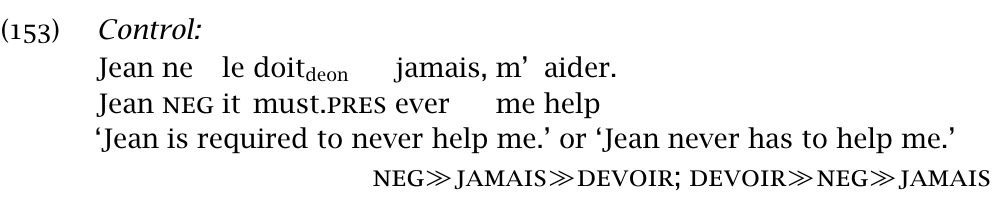
Context: The rules of this bowling game state that exactly one pin must remain standing, no matter which one. . .